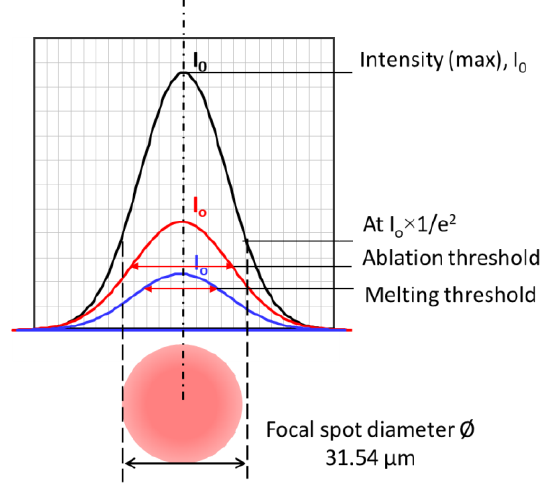
Figure 10. Increase in spot size with pulse energy. Different power percentage p gives different maximum energy intensity I 0 .